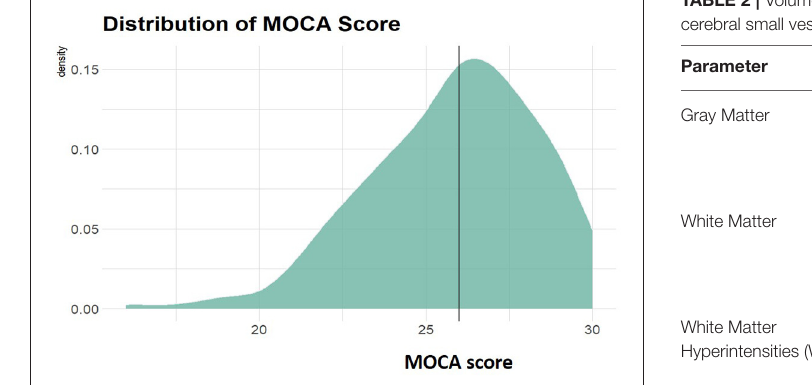
FIGURE 2 | Distribution of MOCA scores among participants. Vertical line indicates 26 points which is a threshold between normal (26–30) and abnormal (0–25) scores.